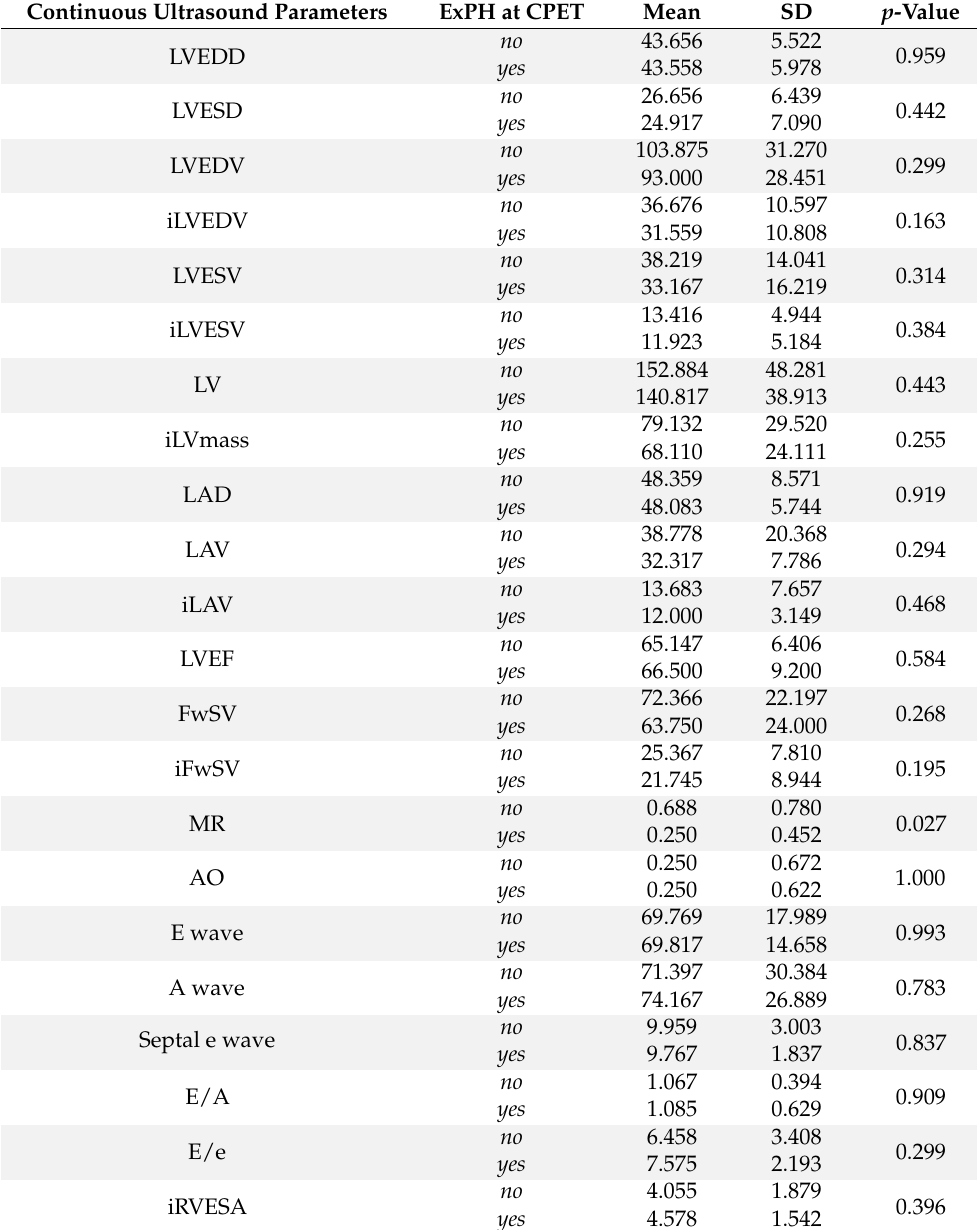
Table A3. ExPH at CPET vs. continuous or categorical ultrasound parameters. Continuous Ultrasound